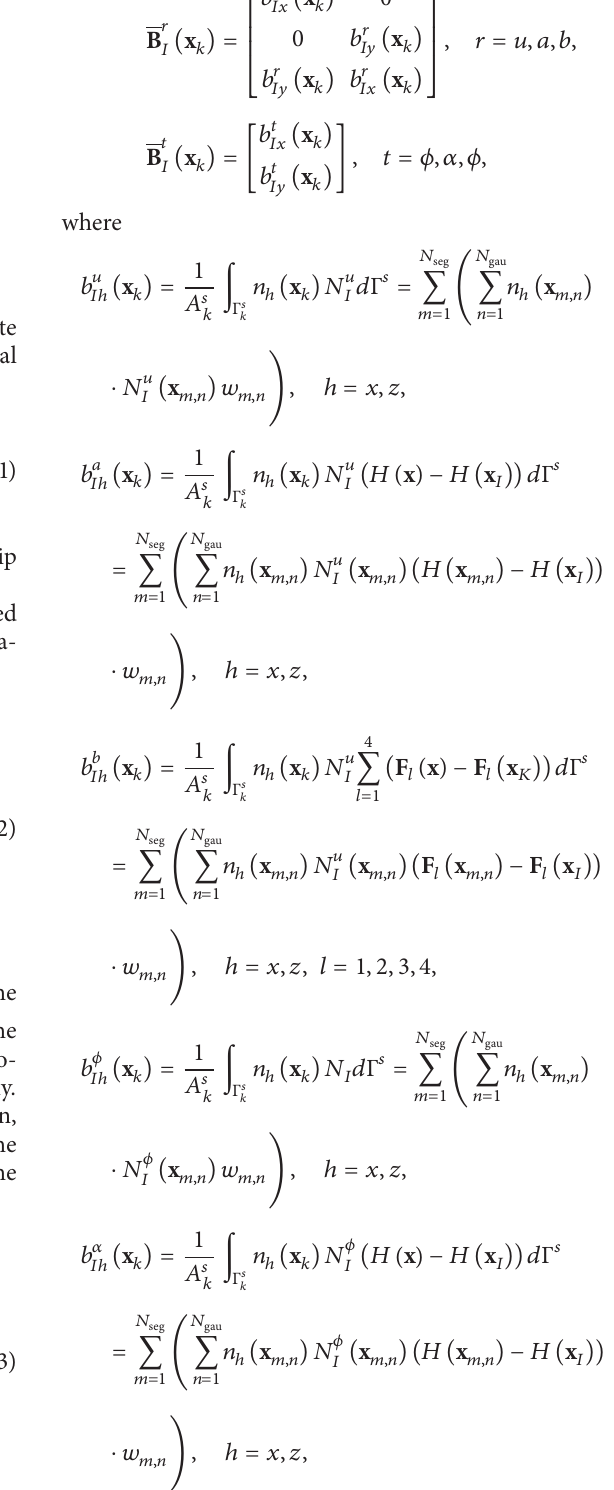
Figure 3: Normal and tangential coordinates for a crack.